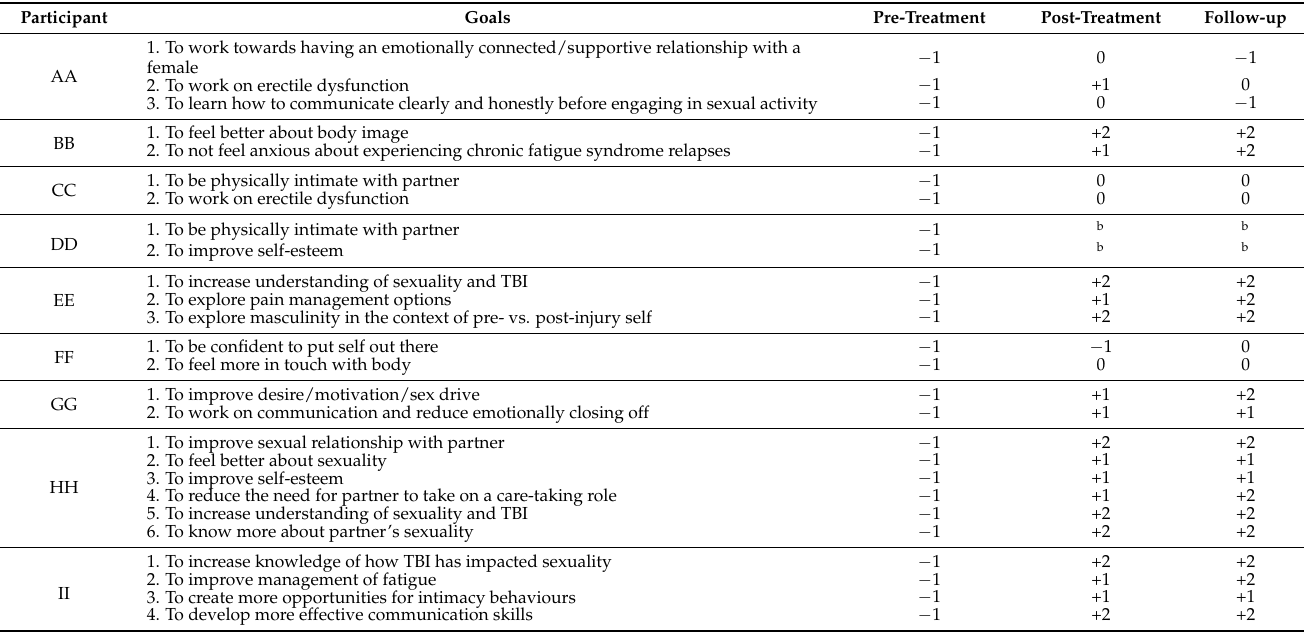
Table 5. Description and attainment of participant GAS